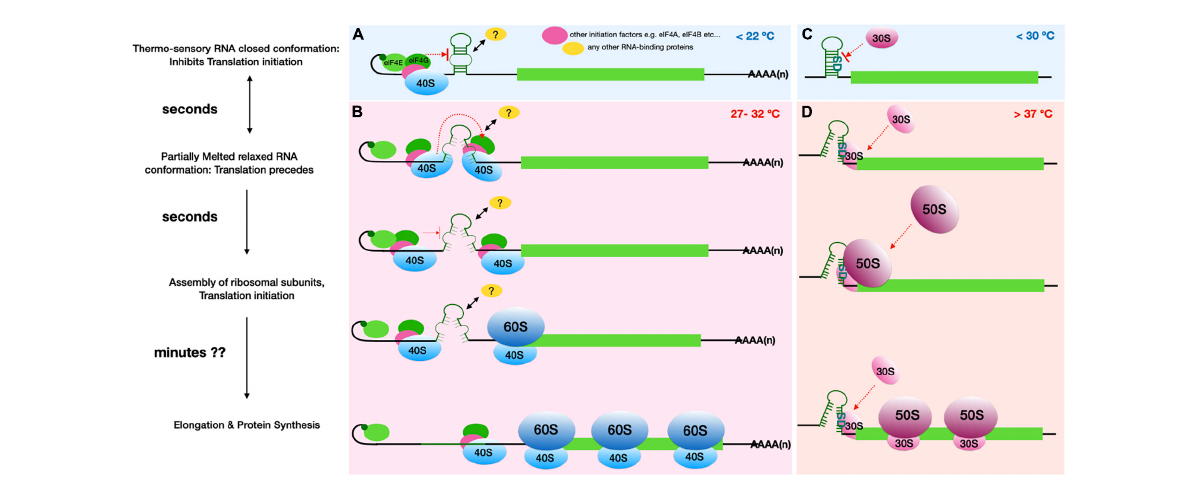
FIGURE1 Comparison of the proposed plant RNA ThermoSwitch mechanism (A,B) with that of known Prokaryotic thermometers (C,D) . (A) The plant RNA ThermoSwitch adopts a closed conformation at temperatures below 22 ◦ C, at which cap-dependent recruitment of 43S complex occurs, however further scanning and identification of the start codon is impeded by the ThermoSwitch. (B) When temperature reaches between 27 and 32 ◦ C, the ThermoSwitch RNA undergoes reversible partial melting, thereby adopting a relaxed conformation and allowing the 43S complex to precede scanning. The partially open conformation temporarily impedes further incoming scanning subunits until the preceding 43S complex encounters the start codon with sufficient initiation context, thereby facilitating 48S initiation complex formation followed by recruitment of the 60S ribosomal subunit. Thus, the switch from closed (<22 ◦ C) to relaxed conformation at 27-32 ◦ C may enhance translation whereby translation initiation rates are selectively increased at higher temperatures (Chung et al., 2020). The fully mature 80S ribosomes then enter the elongation stage of translation allowing protein synthesis, by which time ( ∼ minutes) the ThermoSwitch RNA fully melts accompanied by the helicase activity of incoming scanning 43S complexes. It is also possible that the ThermoSwitch recruits an RNA binding protein, either at the stable conformation to further stabilise the ThermoSwitch at lower temperature (<22 ◦ C), or at the relaxed conformation to enhance 43S scanning. (C) The prokaryotic RNA thermometers operate by a distinct mechanism, since translation initiation here is dependent on the direct interaction of 16S rRNA within the 30S ribosomal subunit and the SD-sequence. The bacterial RNA thermosensors are typically located very close to the start codon and encompass the SD sequence preventing access to the initiating small ribosomal subunit. (D) At higher temperatures (>37 ◦ C), the RNA secondary structure either melts (e.g., ROSE element) or switches into an alternative structure (e.g., CspA cold shock transcript); both processes relieve the SD sequence from intra-molecular base pairing to allow interactions with the 30S ribosomal subunit and recruitment of 50S ribosomal subunit (Kortmann and Narberhaus, 2012). The fully assembled 70S ribosomes then proceed to elongation. Thus, translational induction mediated by prokaryotic RNA thermometers in cis is generally proportional to temperature: the higher the temperature, the less stable is the respective RNA secondary structure and therefore the more efficient is translation initiation. In both instances, translation initiation occurs within seconds of temperature rise while entry into elongation and complete protein synthesis may occur within